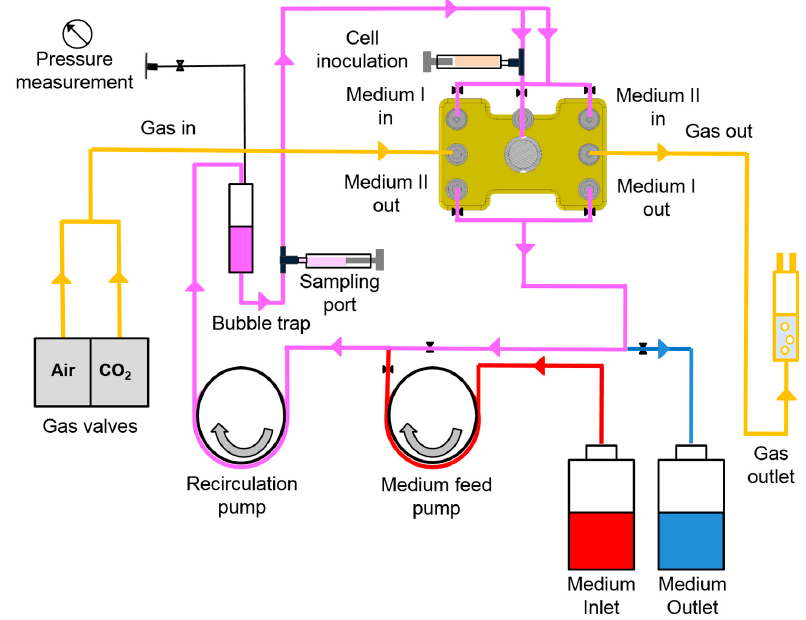
Figure 2. Schematic illustration of the bioreactor perfusion circuit. The bioreactor is integrated into a tubing circuit with continuously recirculating medium (purple). Fresh medium (red) is infused into the circuit via the medium feed pump while used medium (blue) is rinsed out from the circuit upon hydrostatic pressure increase. The tubing circuit contains a bubble trap connected with a line for pressure measurement and is equipped with connections for sample taking. Furthermore, the bioreactor is perfused with a defined air/CO 2 mixture (yellow), which is generated by means of electronically controlled gas valves.